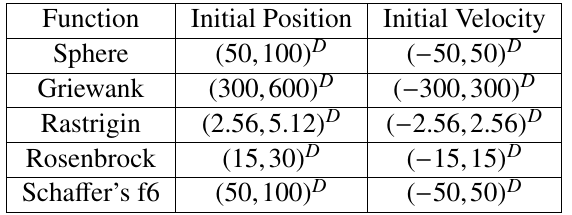
Table 1: The initial position and velocity of the swarm